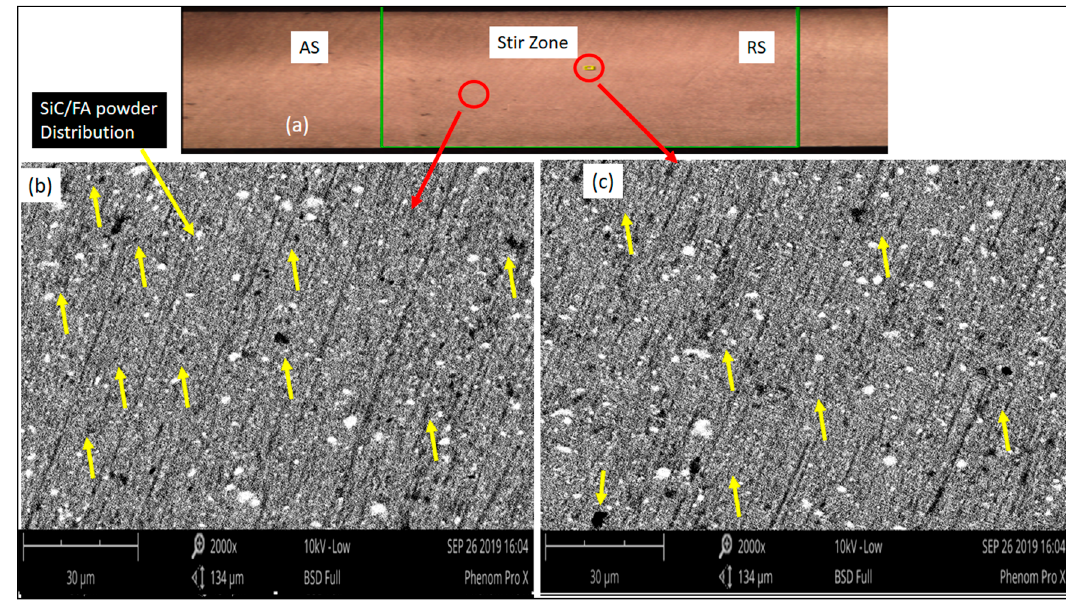
Figure 4. The SEM micrographs of Run 20 AA7075-SiC/FA composite showing ( a ) stir zone cross-sectional view ( b , c ) (2000× magnification) FA/SiC particles distribution in the stir zone.